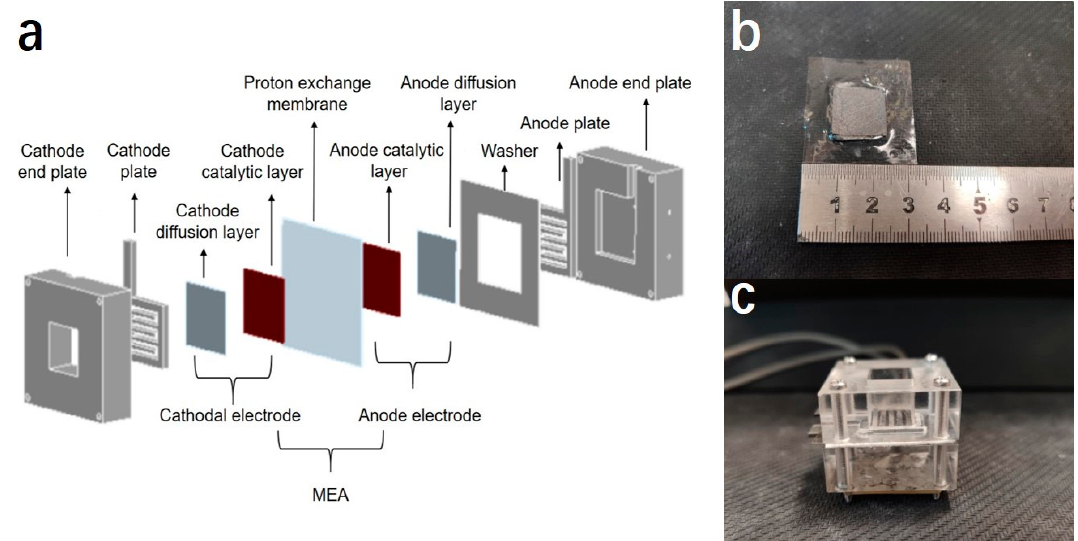
Figure 1. ( a ) Basic structure of the micro direct methanol fuel cell; ( b ) the prepared membrane electrode assembly (MEA); ( c ) assembled micro direct methanol fuel cell.